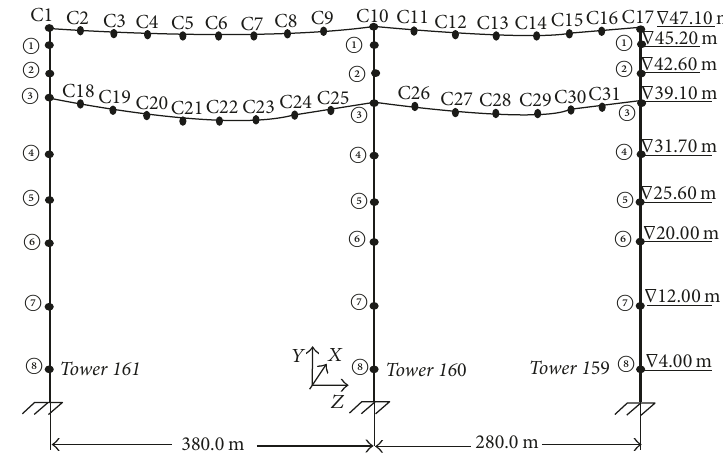
Figure 10: The representative nodal positions of the transmission tower-line system in the wind